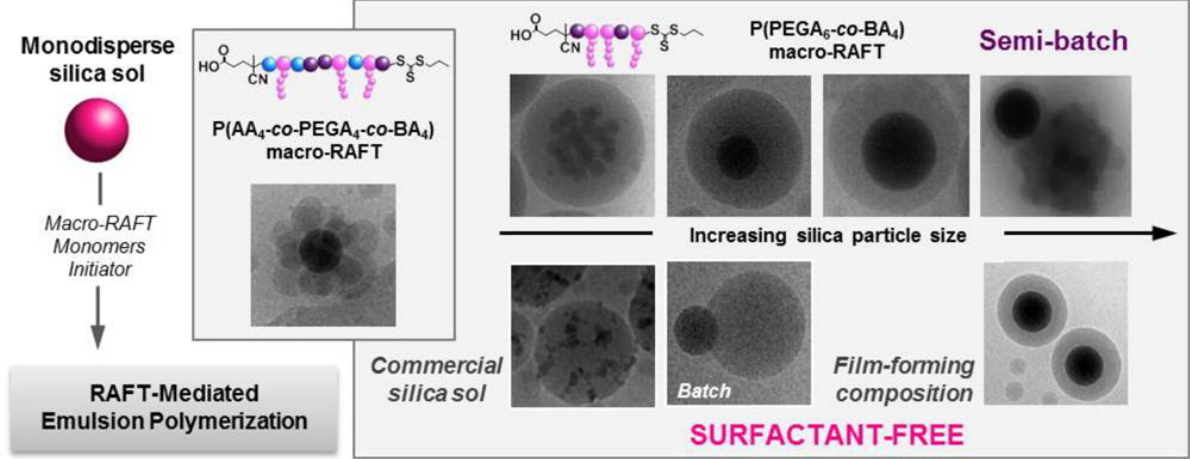
Figure 8. Illustration for the formation processes hybrid latexes by surfactant-free RAFT-mediated emulsion polymerization. Reprinted with permission from ref. [116]. Copyright 2016 ACS.